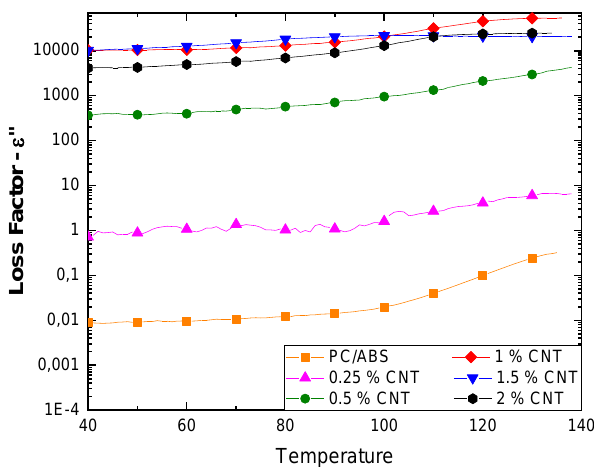
Figure 3. E ff ect of temperature on loss factor of melt-blended carbon nanotubes (CNTs)- Figure 3 . Effect of temperature on loss factor of melt-blended carbon nanotubes (CNTs)-PC/ABS PC / ABS composites. composites.